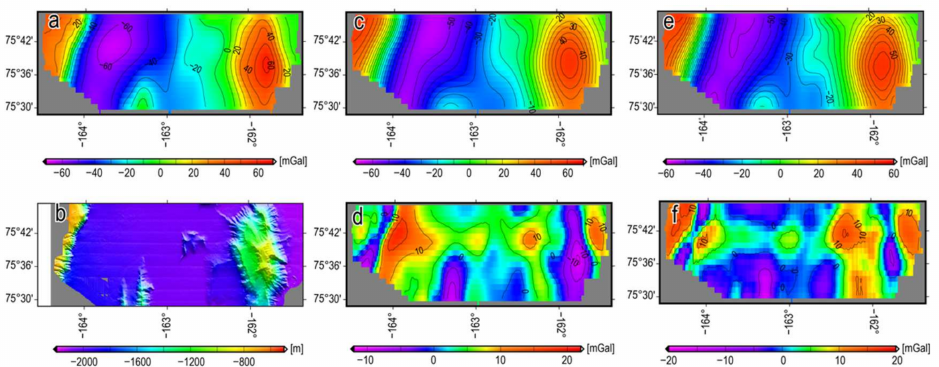
Figure 6. ( a ) Shipborne FAA map of Arctic-18. ( b ) Bathymetry of Arctic-18. ( c ) SV31 FAA map of Arctic-18. ( d ) Difference between shipborne and SV31 free-air gravity. ( e ) DTU21 FAA map of Arctic-18. ( f ) Difference between shipborne and DTU21 free-air